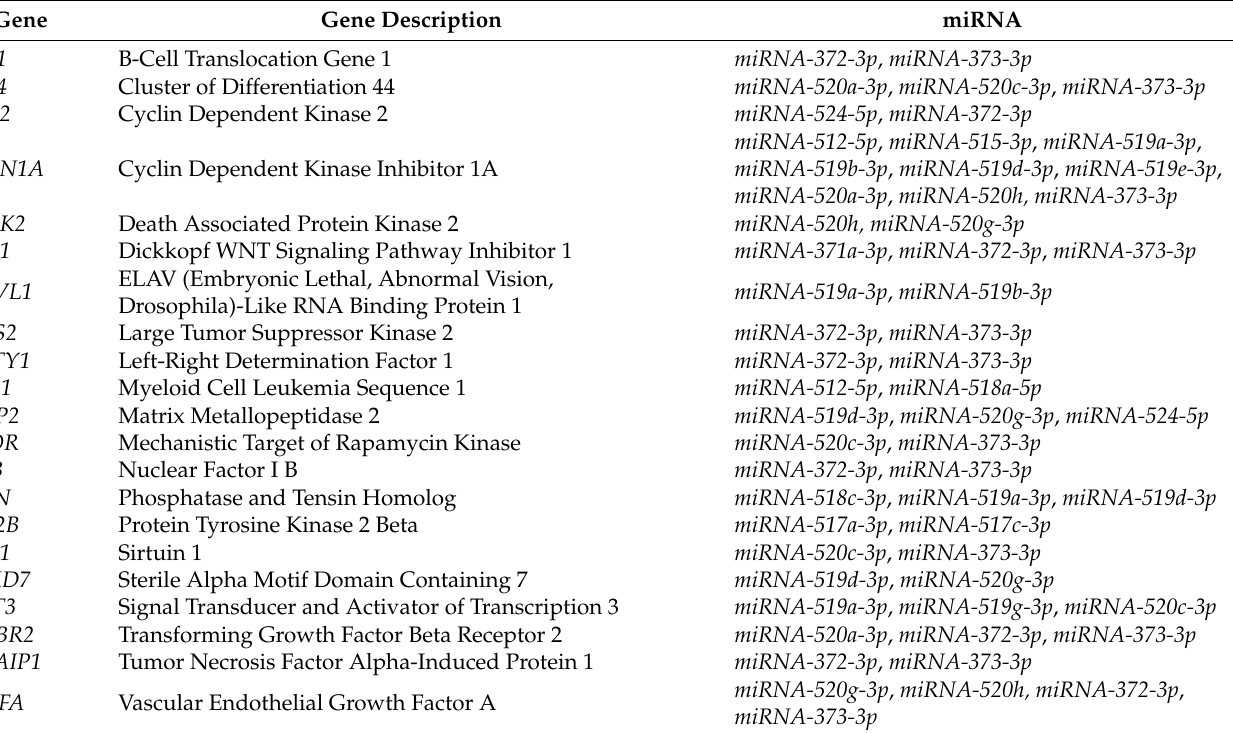
Figure 3. Methylation levels of the C19MC and MIR371-3 clusters components according to the histological subtype of lung cancer. ( A ) C19MC methylation levels in patients with squamous cell carcinoma (SCC) relative to the control group is represented in purple bars, whereas methylation levels in patients with adenocarcinoma (ADC) compared to the control group are represented in orange bars. ( B ) Relative MIR371-3 methylation levels in patients with SCC (purple) and ADC (orange) relative to the control group. Relative methylation changes in β values (log 2 ) are represented on the y -axis. Table 2. Common miRNA–target interactions for both C19MC and MIR371-2 miRNA